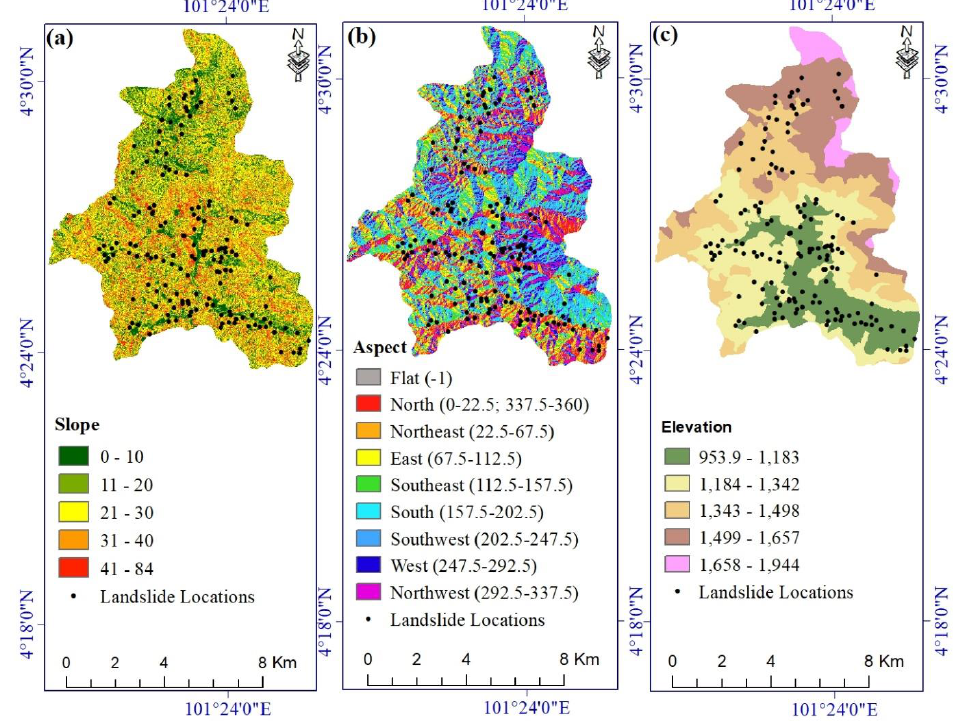
Figure 2. Landslide conditioning factors: ( a ) slope, ( b ) aspect, and ( c ) elevation. Int. J. Environ. Res. Public Health 2020 , 17 , x